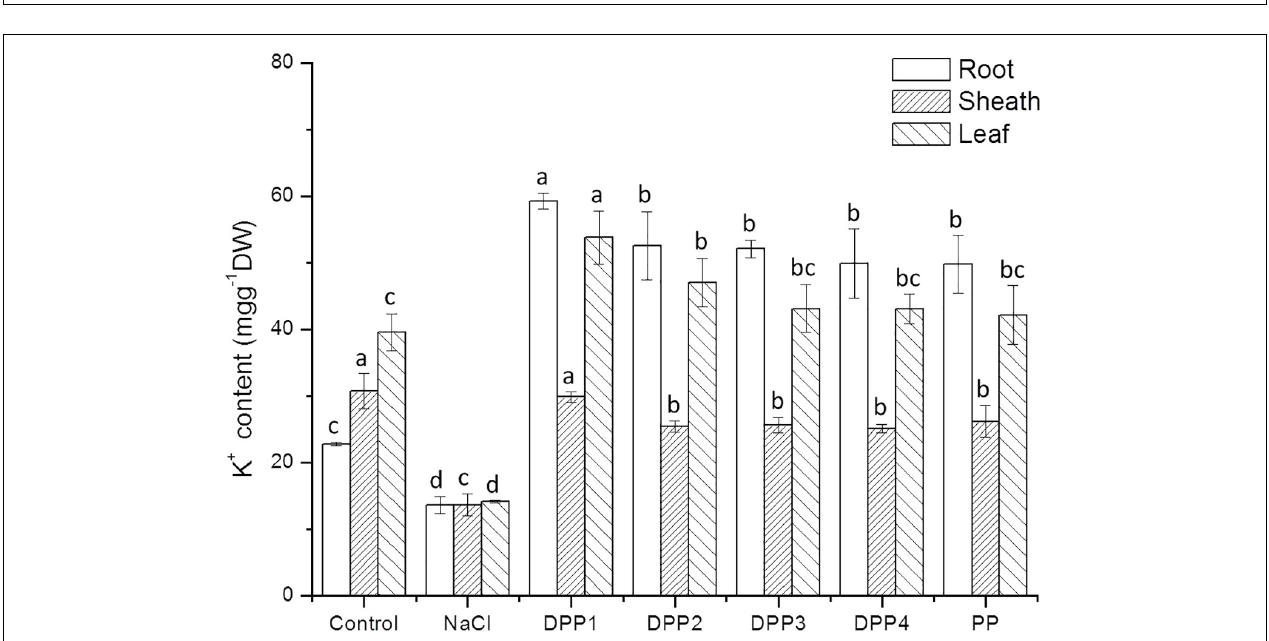
FIGURE 7 | Effect of four degraded (DPP1,2,3,4) and natural polysaccharides (PP) from P. yezoensis on K + contents of root, sheath, and leaf in wheat seedlings. Values are the mean ± SD of three replicates. Different letters indicate significant differences at P < 0.05.